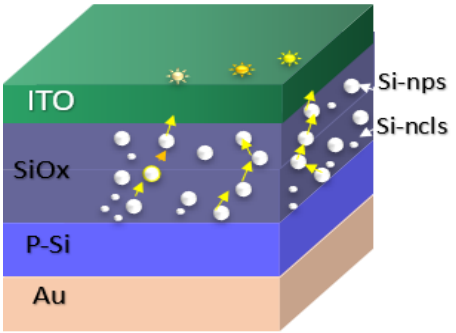
Figure 10. S1 structure schematic of the conductive paths within the SRO